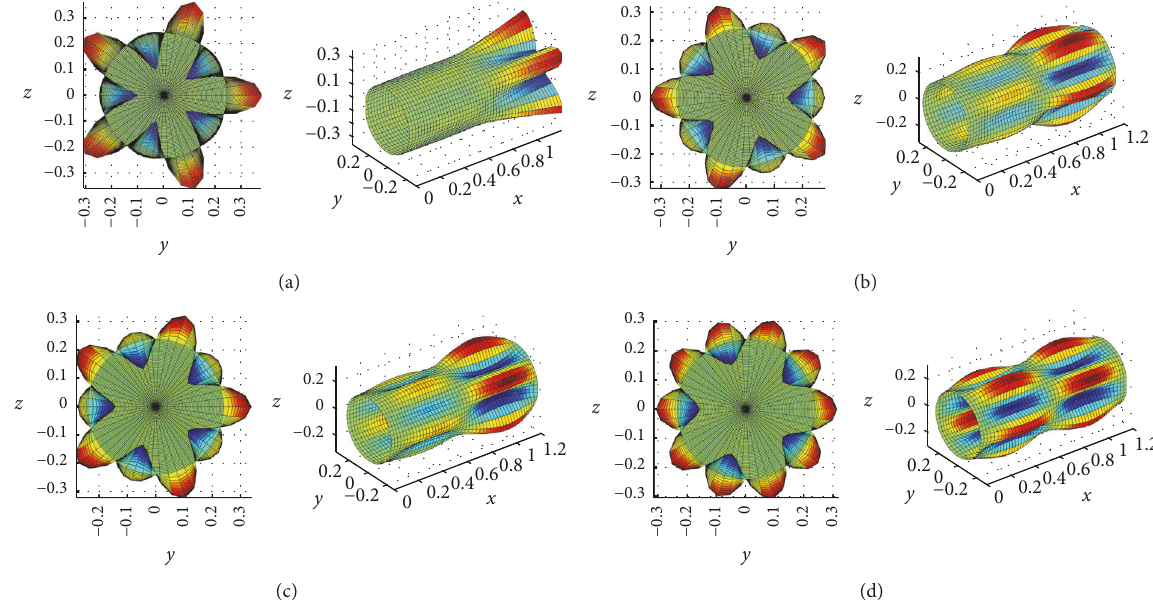
Figure 11: The 𝑆(1,5) modes of coupled structures with C-E boundary condition: (a) 𝑘𝑥 = 𝑘𝜃 = 𝐾𝑟 = 0 and 𝑘𝑟 = 1𝐸4 , 213.41Hz; (b) 𝑘𝑥 = 𝑘𝜃 = 𝐾𝑟 = 0 and 𝑘𝑟 = 1𝐸8 , 308.64 Hz; (c) 𝑘𝑥 = 𝑘𝜃 = 𝐾𝑟 = 0 and 𝑘𝑟 = 1𝐸12 , 311.27 Hz; and (d) C-C, 358.82